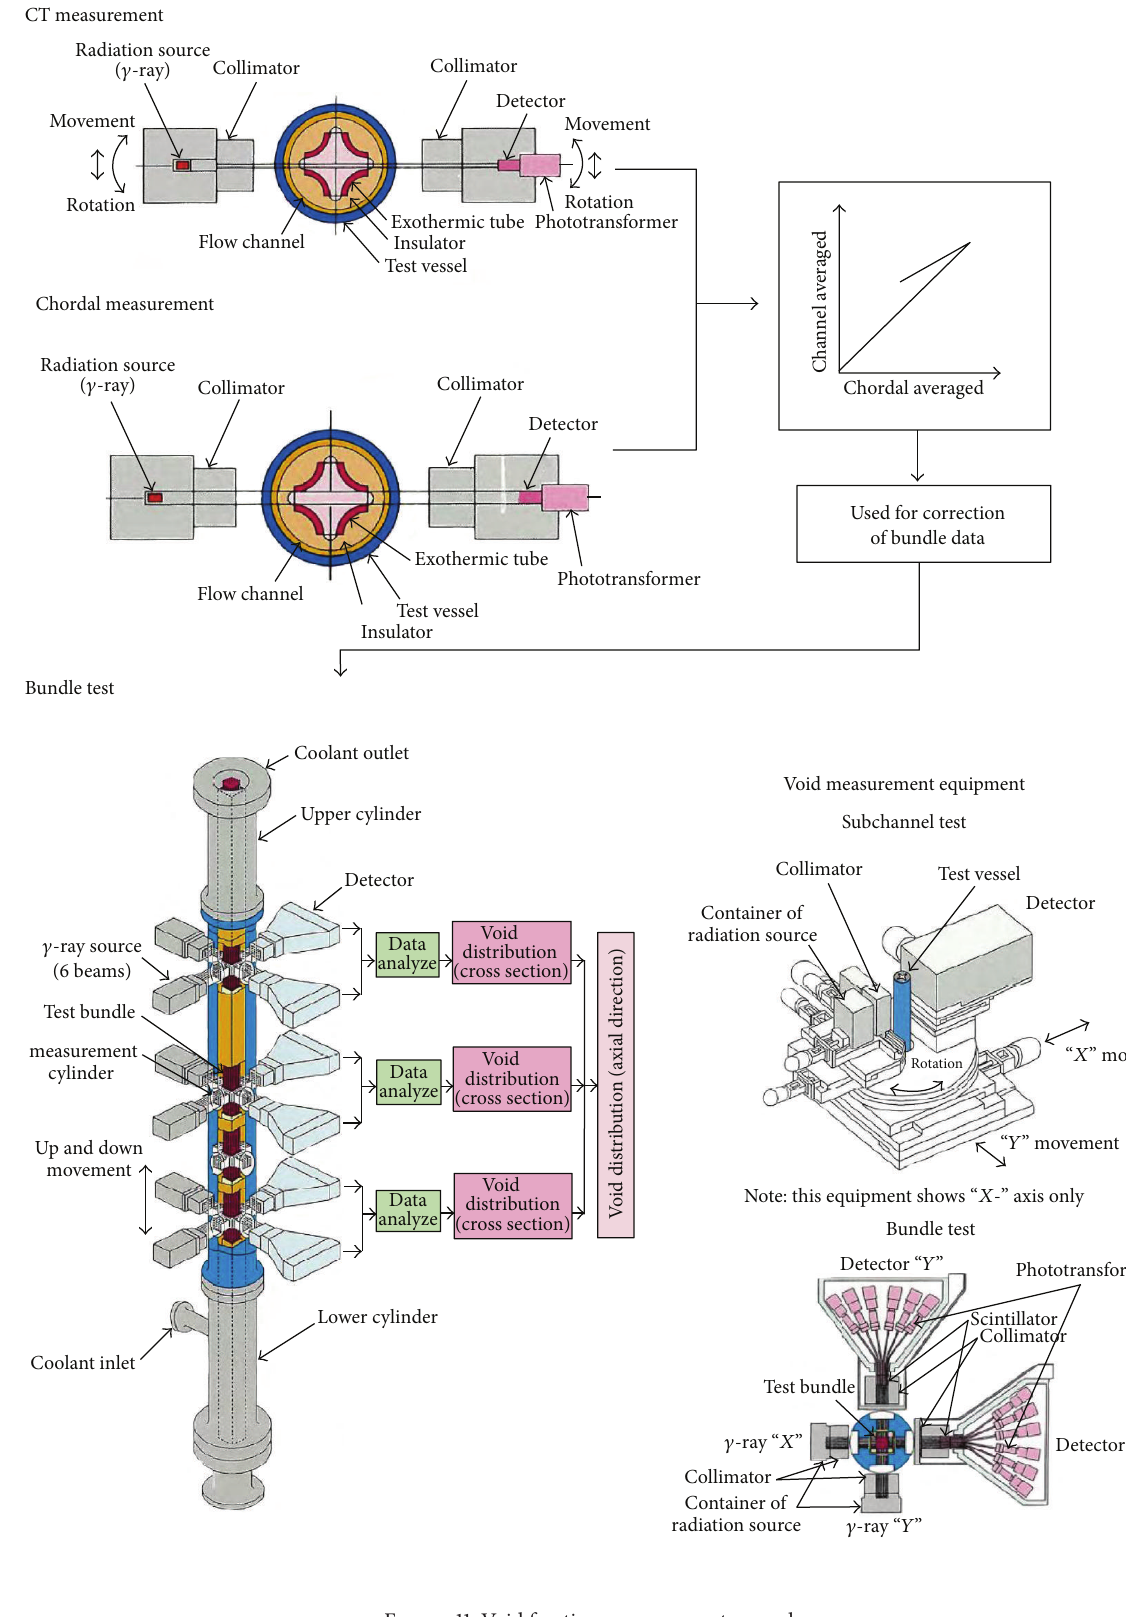
Figure 11: Void fraction measurement